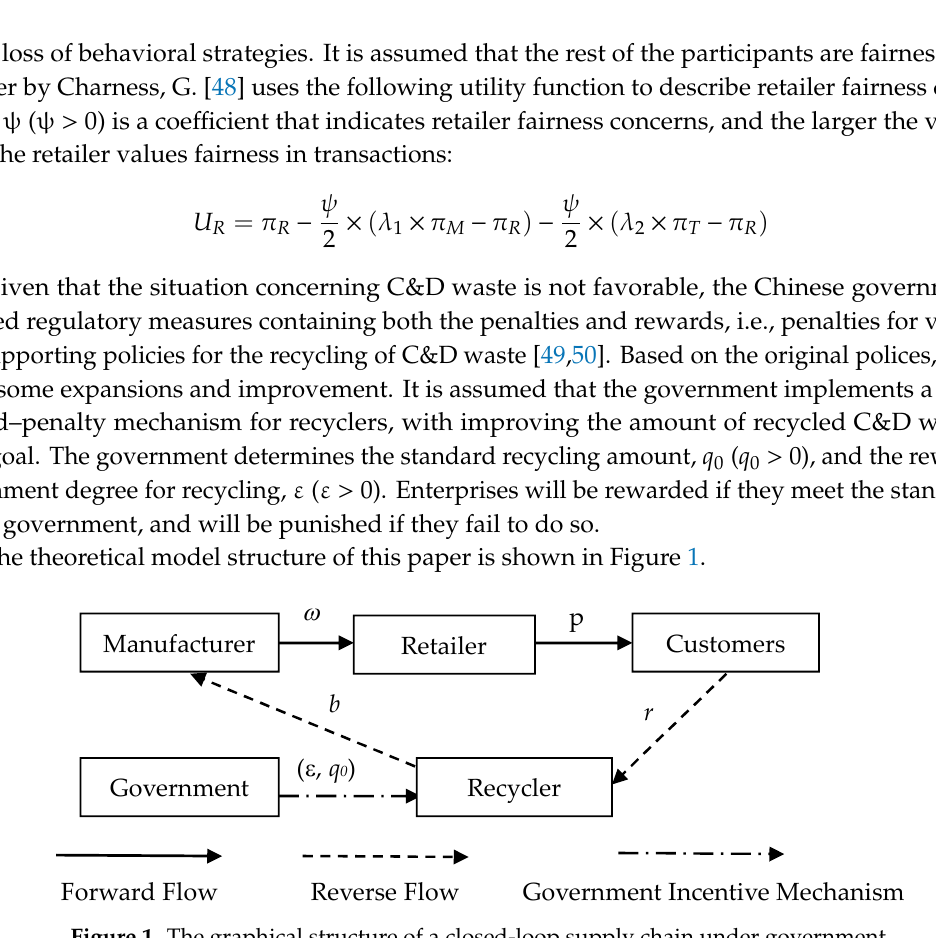
Figure 1. The graphical structure of a closed-loop supply chain under government